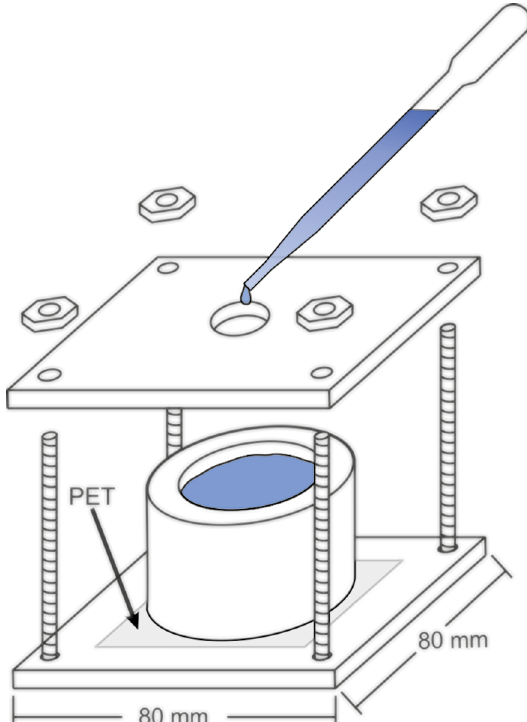
Figure 1. Accessory used for the PET chemical attack